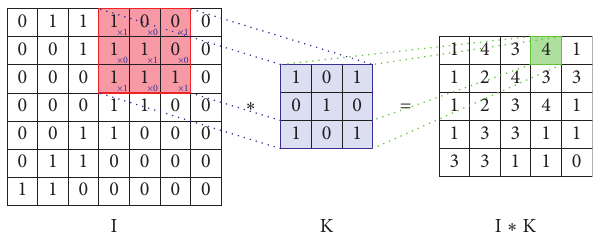
Figure 3: 2D convolution level function of a CNN [26].